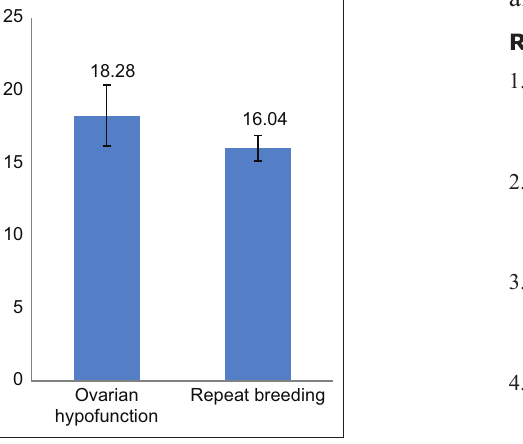
Figure-2: Average calving intervals in beef cattle with ovarian hypofunction and repeat breeding in Jepara Regency.